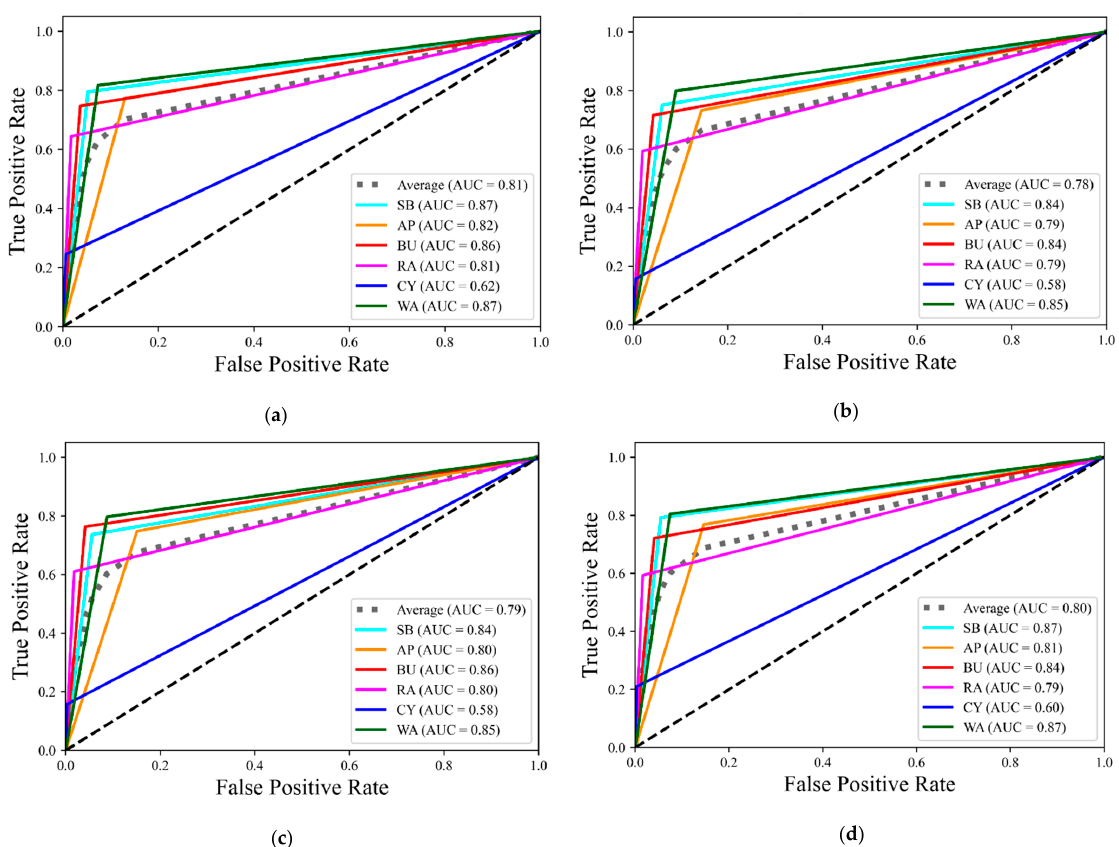
Figure 5. The area under the curve of receiver operating characteristic curves: ( a ) MOHT, ( b ) random search, ( c ) Hyperopt, and ( d ) grid search; SB: school bus, AP: automobile as a passenger, BU: bus, RA: rail transit, CY: cycling, WA: walking.